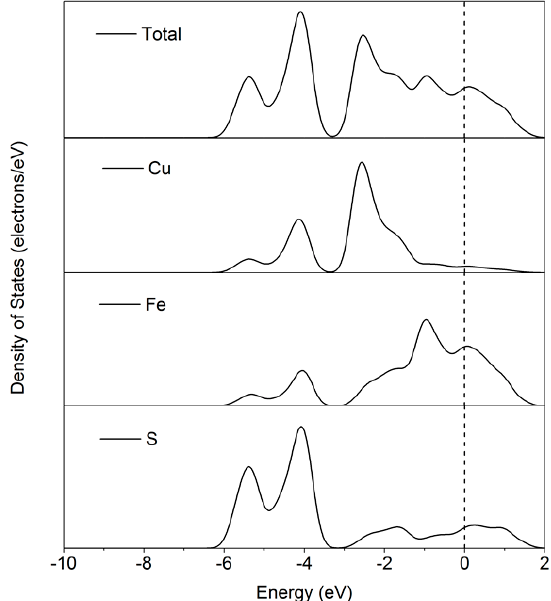
Figure 4. Density of states of chalcopyrite (001)-S surface.